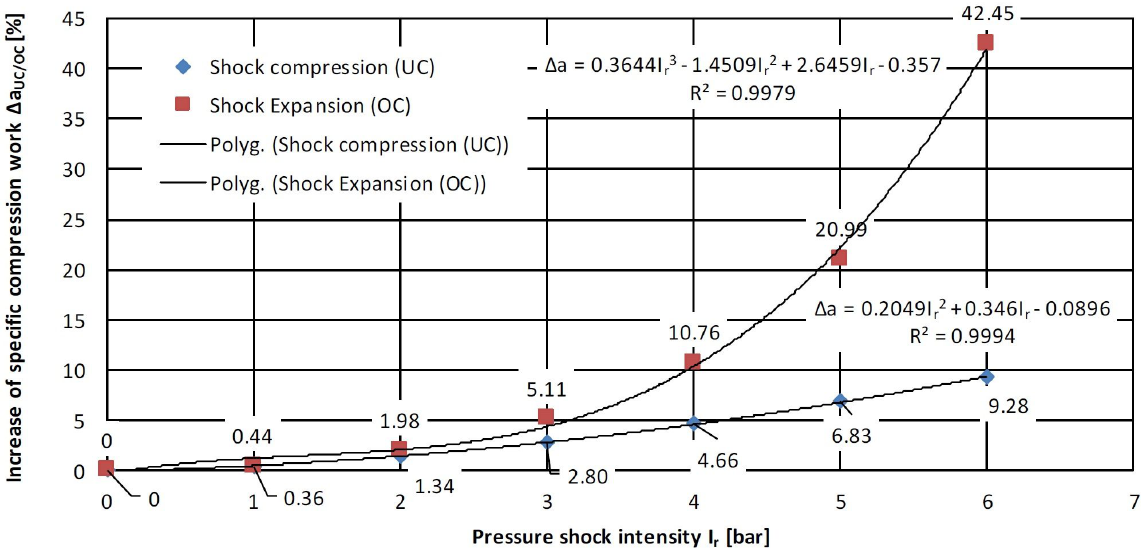
Figure 4: Diagram of increase (change) of specific compression work needed to compress ideal gas in dependence on the intensity of the Shock compression (UC) and the Shock expansion (OC)